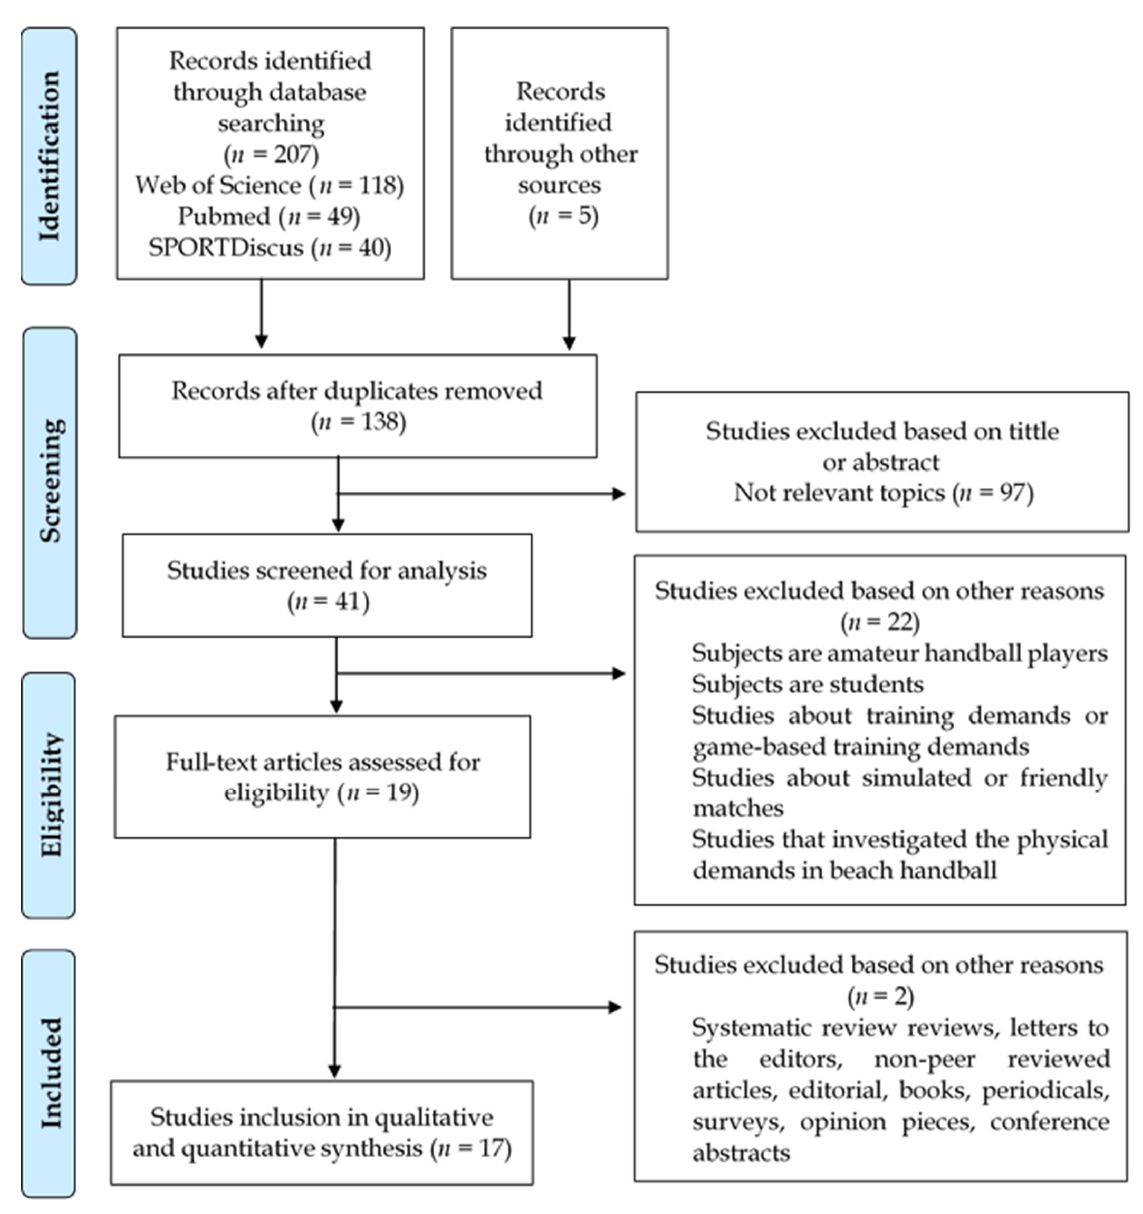
Figure 1. Flow diagram for screening and selection of studies according to Preferred Reporting Items for Systematic Reviews and Meta-Analysis (PRISMA).